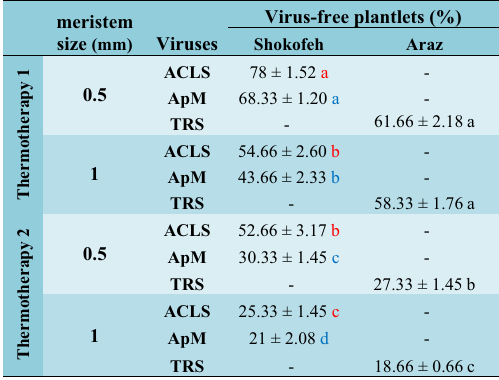
Table 5. Interaction effects of each of 2 cultivars × 2 sizes of meristem × 2 thermotherapy treatments on the percentage of virus elimination. (n = 3, p < 0.01, ±